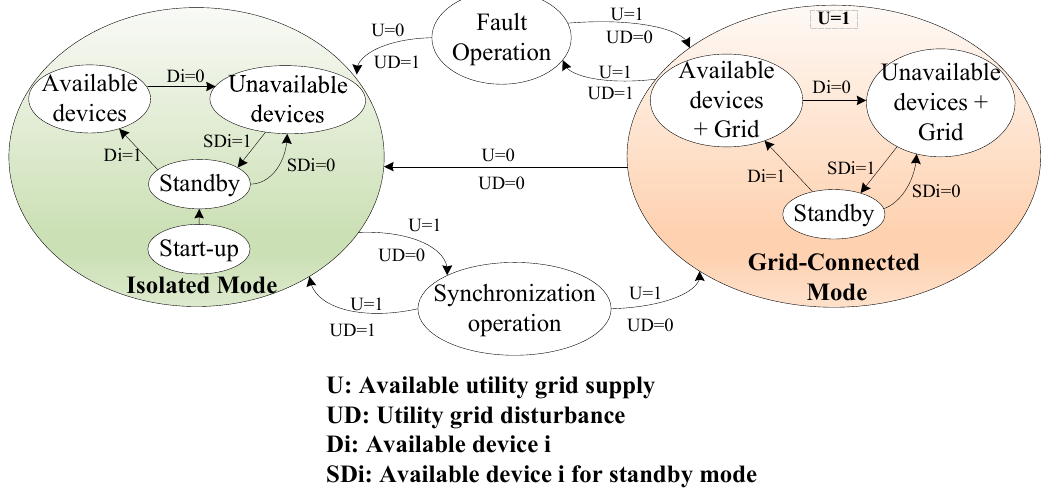
Figure 2. The state diagram of microgrid operation.